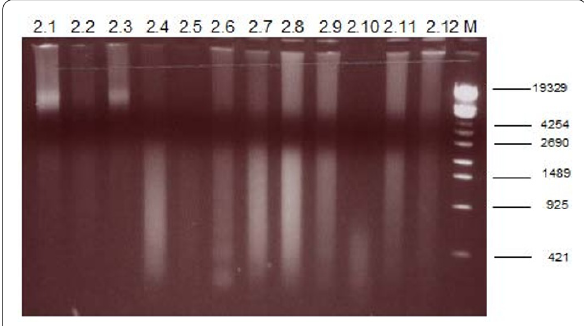
Figure 2 1% gelelectrophoresis of DNA extracts prepared for the second trial . M: DNA length standard λ/Eco130I (Fermentas, St. Leon- Roth,